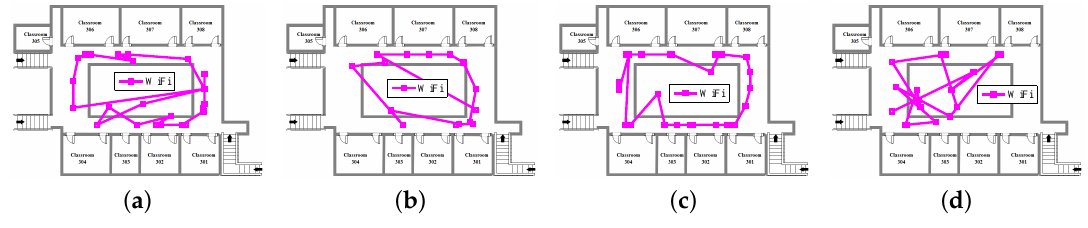
Figure 6. Positioning results for WiFi: ( a ) calling; ( b ) dangling; ( c ) handheld; and ( d ) pocket.